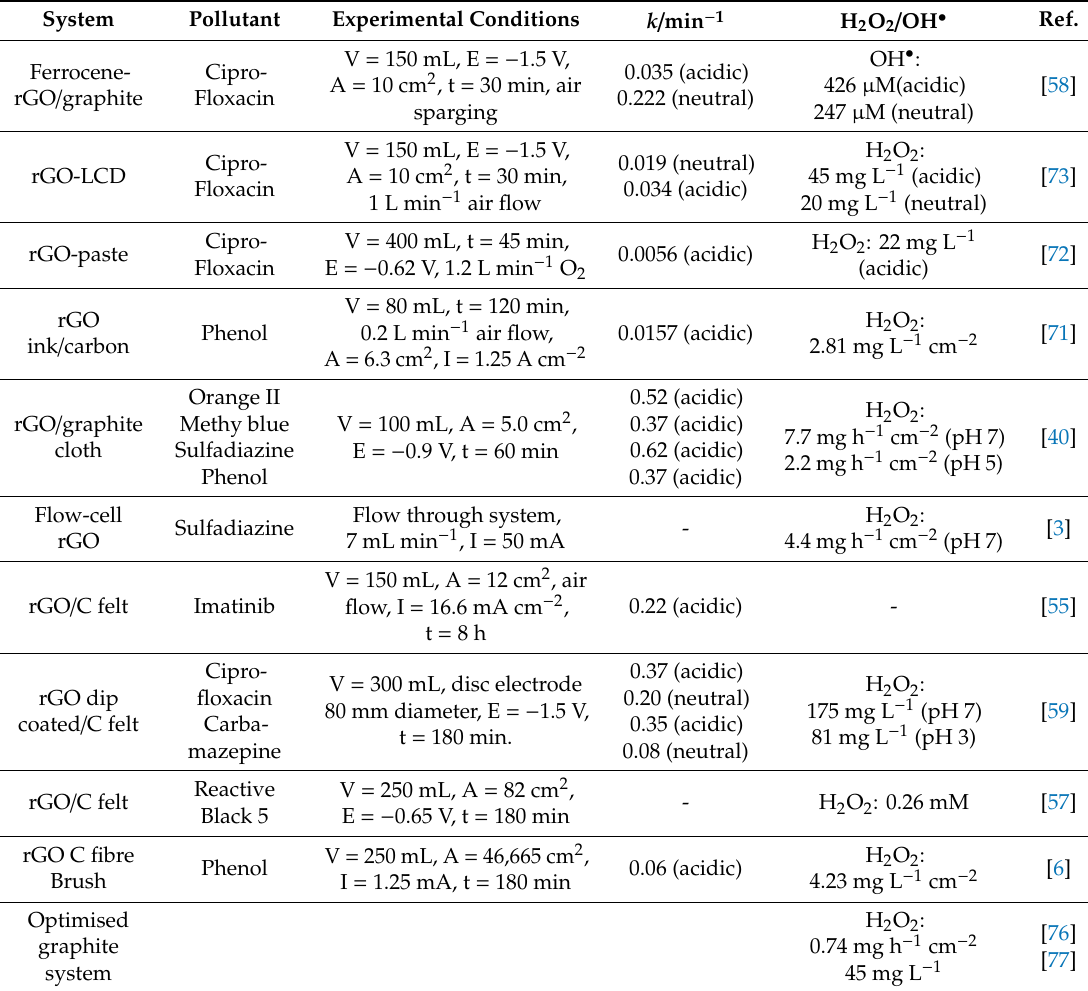
Table 1. Summary of graphene-based felt electrodes in generating H 2 O 2 or OH • and in the removal of